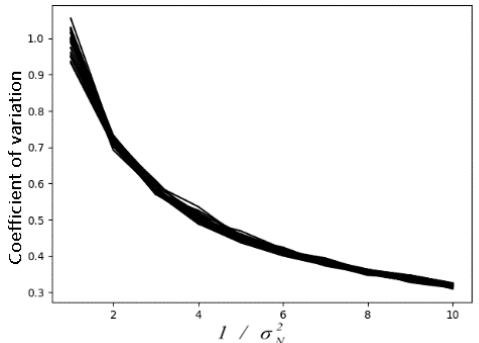
Figure 5. Relationship between the coefficient of variation and noise